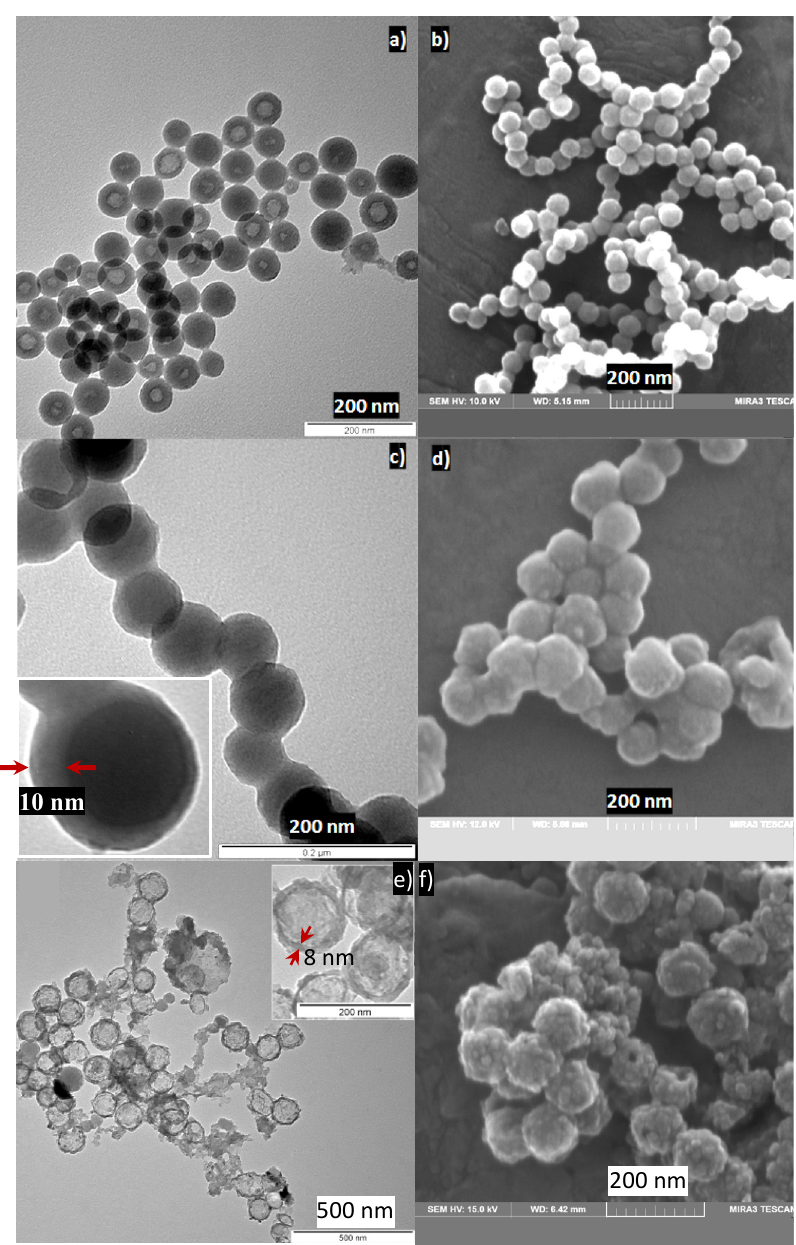
Figure 3. TEM ( a , c , e ) and SEM ( b , d , f ) images showing silica spheres after reverse micelle synthesis ( a , b ), SiO 2 @HTC after hydrothermal carbonization ( c , d ), and empty hollow carbon spheres after silica removal ( e , f ), respectively.